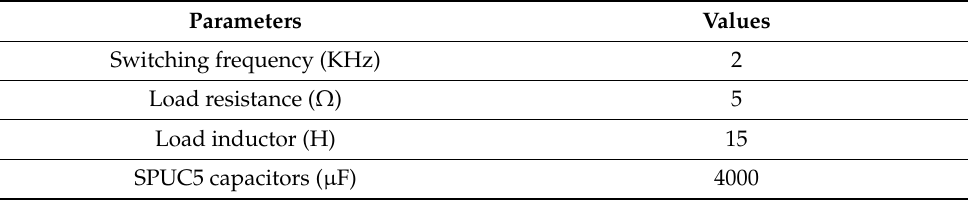
Table 3. Simulation